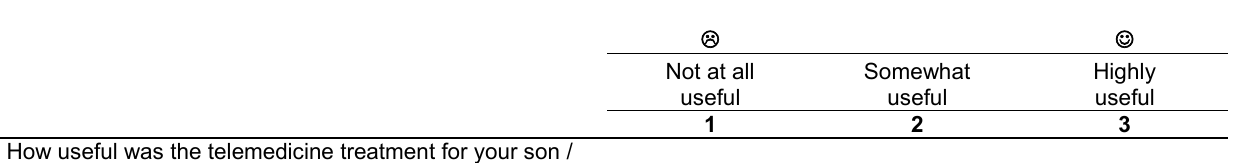
Enrollment Assessed for eligibility (n=16)